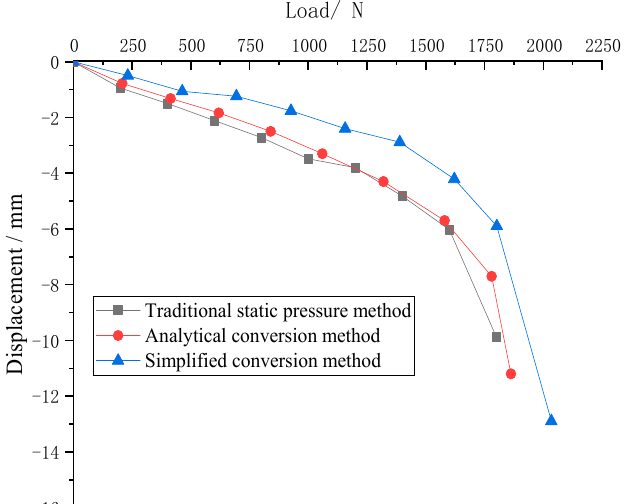
Figure 12. The Q-s curves of equivalent conversion of self-balanced test piles and conventional static test piles.